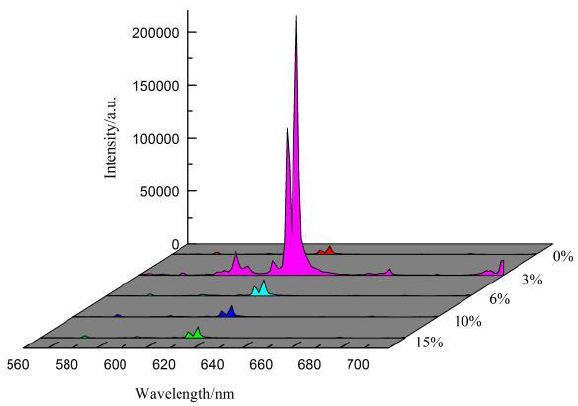
Figure 11. Emission spectra of SrMo 0.5 W 0.5 O 4 :Eu 3+ with different concentrations of NH 4+ . Figure 12 shows the luminescence decay curves of SrMo 0.5 W 0.5 O 4 :Eu 3+ phosphors doped with several charge compensators (K + , Li + , Na + , NH 4+ ) at an excitation wavelength curves of all samples’ emitted light satisfy a bi-exponential equation [38]: